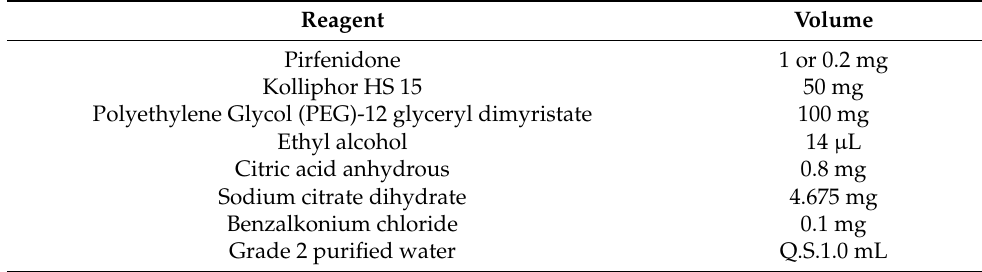
Table 1. Pirfenidone-loaded liposomes formulation composition.